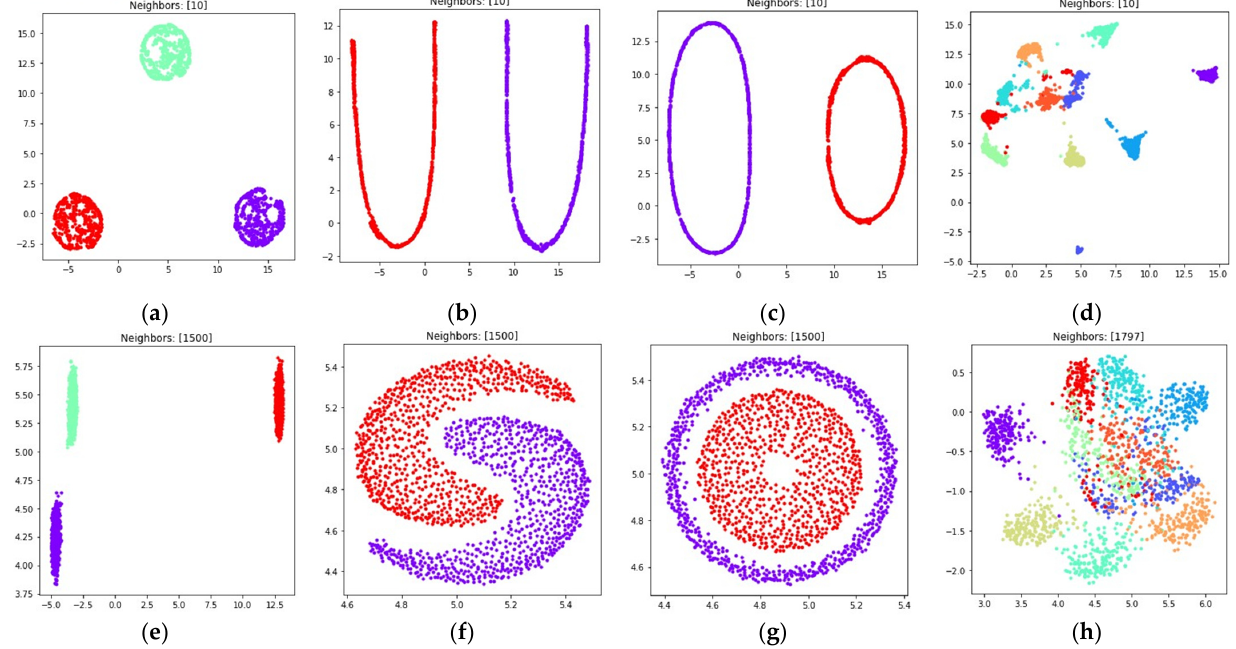
Figure 7. Locations of objects in R 2 with dimensionality reduction performed by applying the UMAP algorithm, with low dimensional embedding optimized by the Adam algorithm and the gradient (32) with d min set to 0.1 for: ( a ) blobs, k = 10; ( b ) moons, k = 10; ( c ) circles, k = 10; ( d ) handwritten digits, k = 10; ( e ) moons, k = ( n − 1 ) ; ( f ) blobs, k = ( n − 1 ) ; ( g ) circles, k = ( n − 1 ) ; ( h ) handwritten digits, k = ( n − 1 )